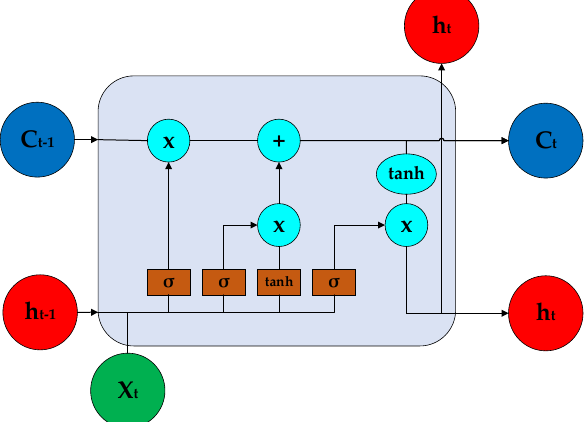
Figure 3. The structure of LSTM.